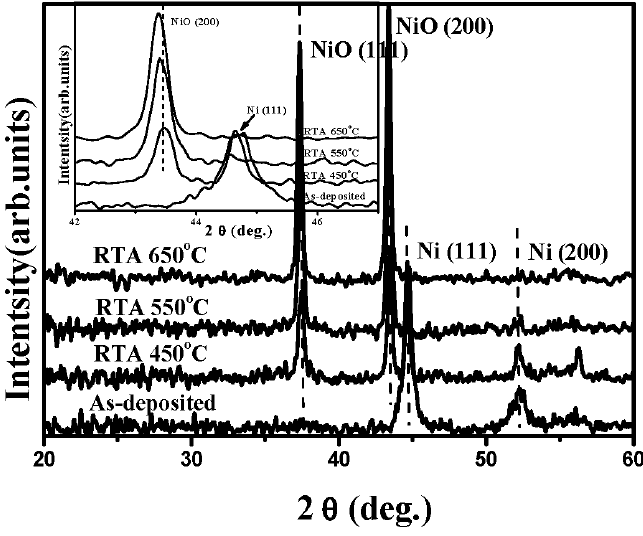
Figure 6. XRD patterns of the as-deposited Ni film and the films annealed at temperatures of 450 °C, 550 °C, and 650 °C, respectively (the inset figure shows a high resolution of the NiO(200) and Ni(111)